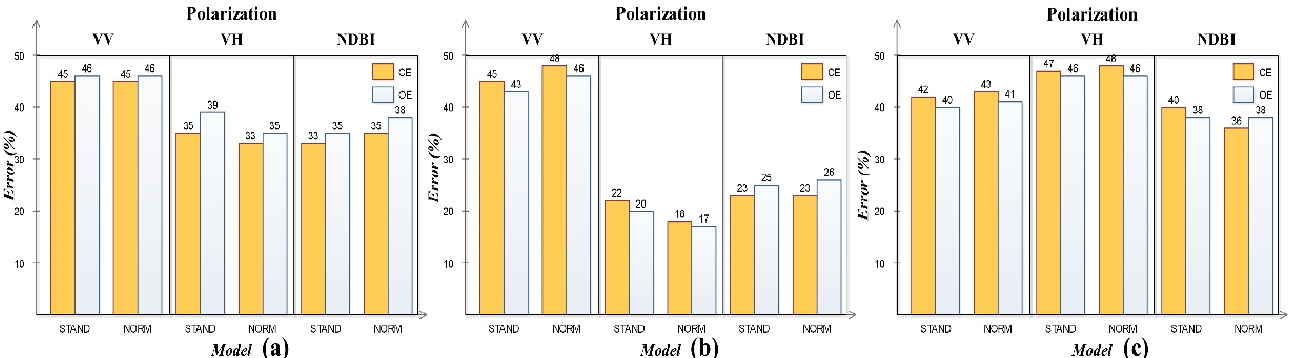
Remote Sens. 2021 , 13 , x FOR PEER REVIEW Figure 5. Estimated severity map using VH polarization data in dry conditions and the STAND model.